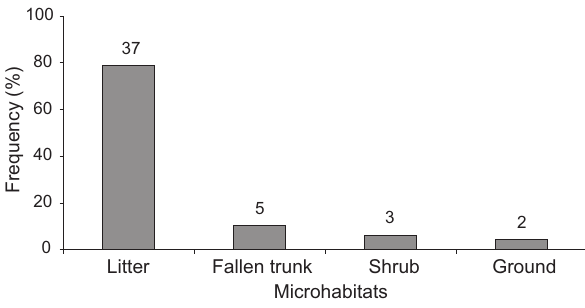
Figure 2. Frequency of use of different microhabitat categories by I. parva in Santuário Ecológico da Serra da Concórdia. Values above the bars indicate the number of individuals.